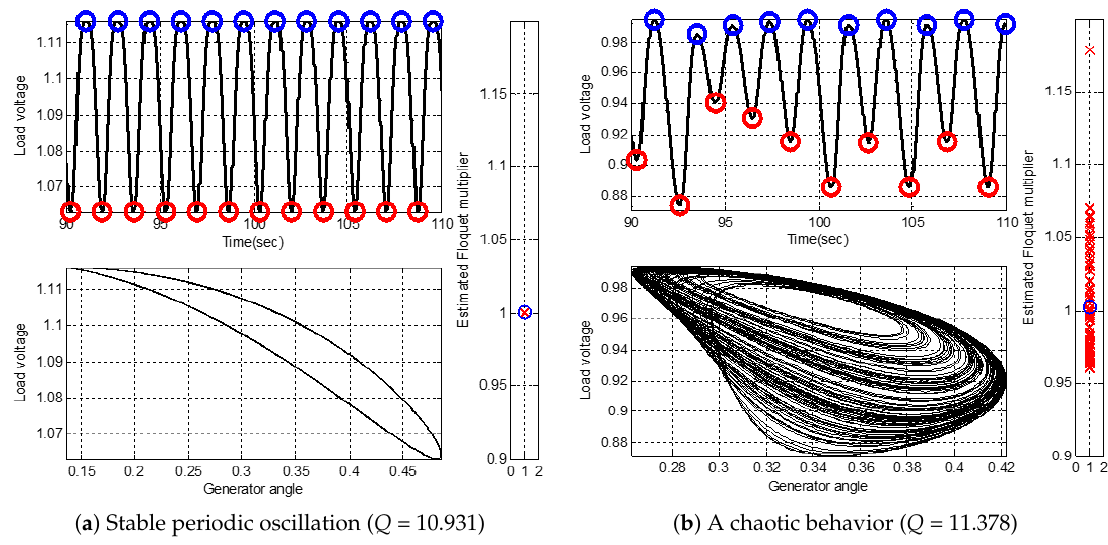
Figure 9. Floquet multiplier estimation for rms value of load